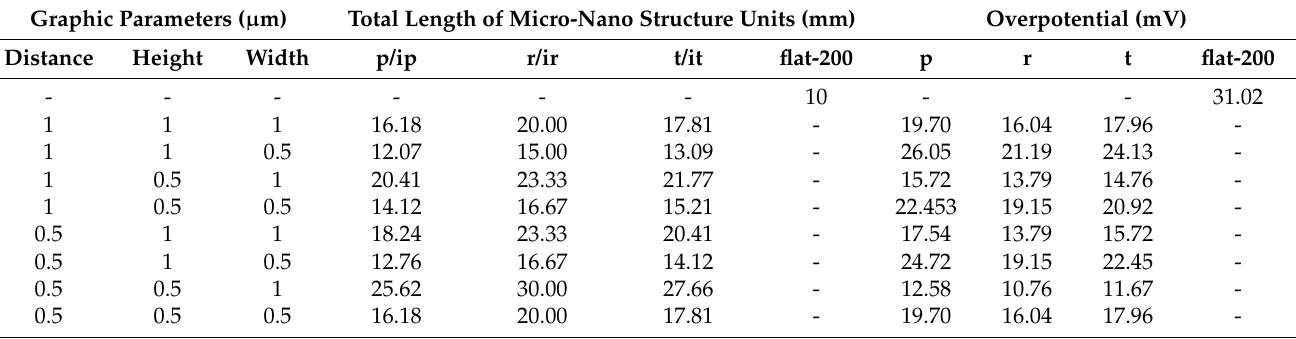
Table 3. The total length of micro-nano structural units and overpotential of each micro-nano surface electrode.